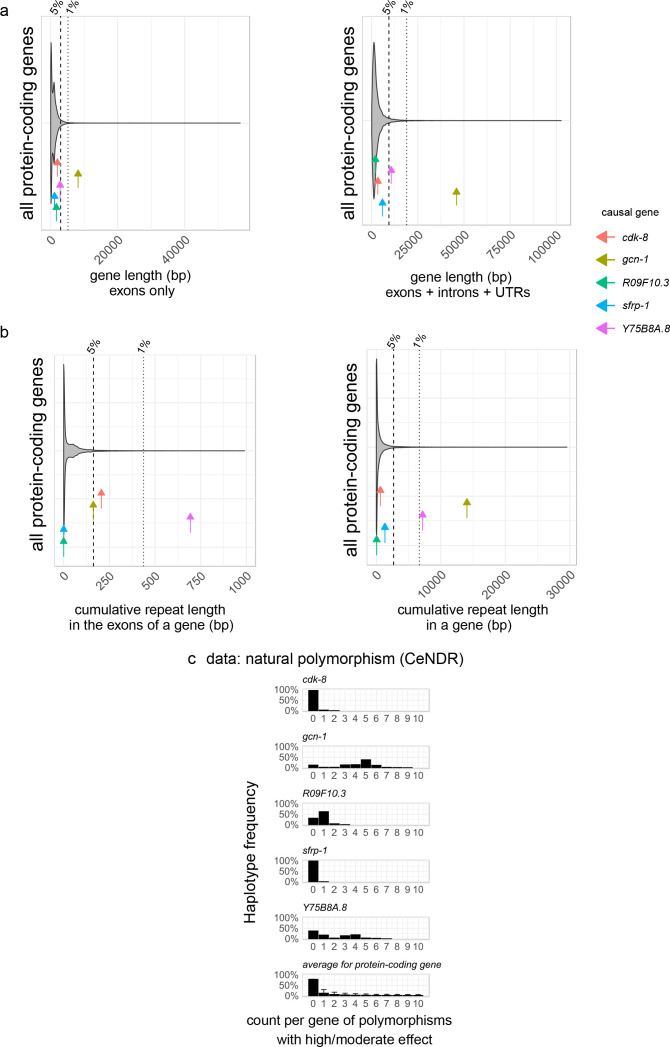
Mutational properties of causative genes.(a) Distribution among protein-coding genes of their total length. The left panel shows the cumulative length of exons only, while the right panels show the length of genes, defined as the primary transcript sequence (including exons, introns and untranslated regions). Colored arrows indicate the value for each causative gene, dashed and dotted vertical line correspond to the upper 5% and 1% quantiles, respectively. (b) Distribution among protein-coding genes of cumulative repeat length in their exons or along their total length. Y75B8A.8 is a poly-Q containing protein and thus an outlier concerning repeats in exons. However, the causal mutation we found does not affect these repeats. (c) Frequencies of haplotypes in the five causative genes at CeNDR (N = 330), as a function of the number of high and moderate impact variants compared to the reference N2 sequence (predicted by snpEff, see Materials and methods). Average frequencies are given for all protein-coding genes in the lower panel.